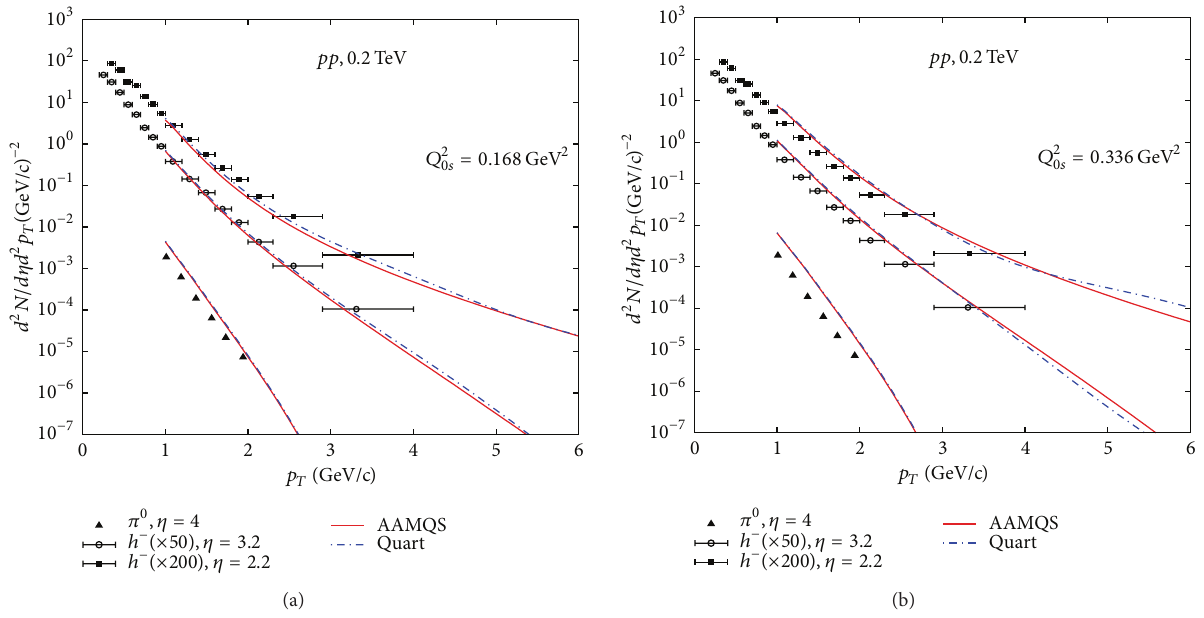
Figure 5: Neutral pion and negatively charged hadron yields in 𝑝𝑝 collisions at √𝑠 𝑁𝑁 = 0.2 TeV. The symbols represent the experimental data at different pseudorapidities measured by the STAR [56] and BRAHMS Collaborations [57]. The solid and dashed-dotted curves represent the results calculated by the AAMQS and quartic action, respectively, with 𝑄 2 0𝑠 = 0.168 GeV 2 (a) and 0.336 GeV 2 (b) in the